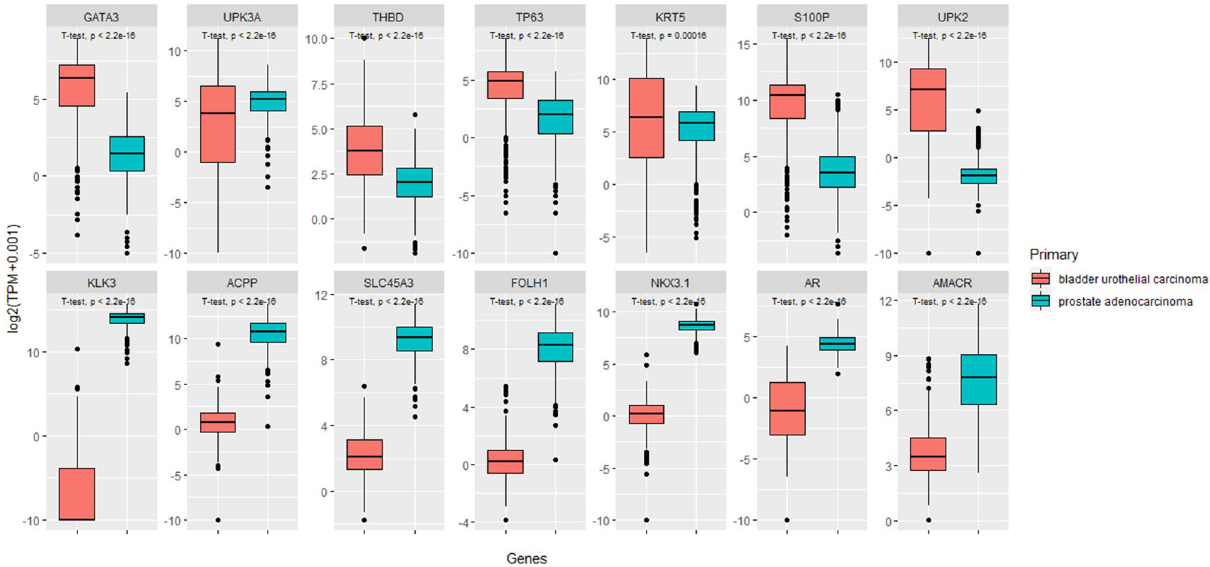
Figure 2. Differential gene expressions for urothelial and prostate lineage markers between bladder urothelial carcinomas and prostate adenocarcinomas (prepared using R version 4.0.3, https:// cran.r- proje ct. org/). Predicted group membership Actual No of cases